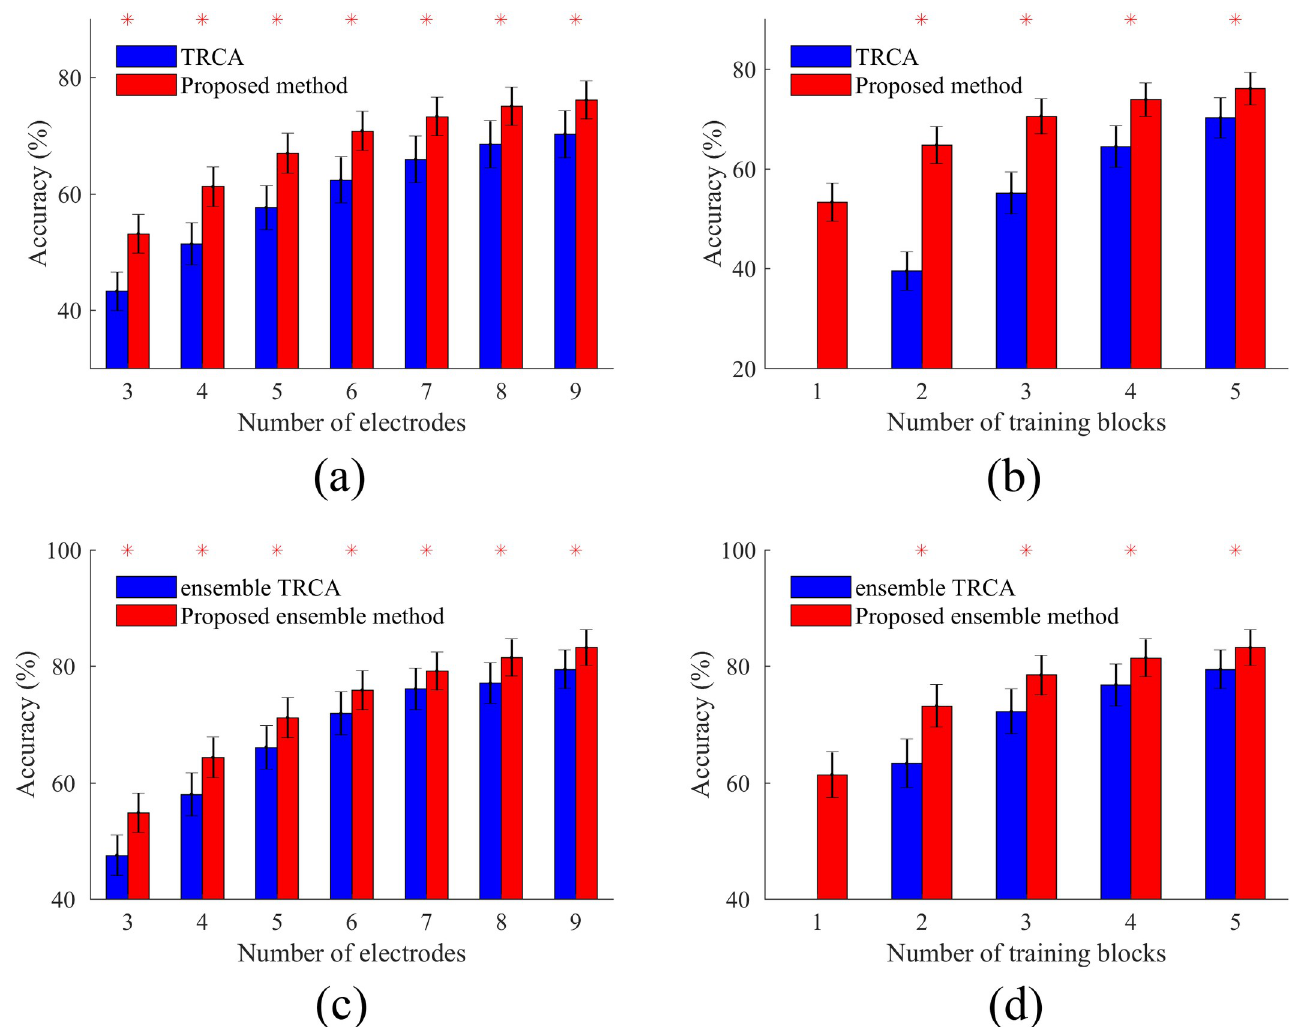
Fig 6. Average accuracies across subjects obtained by different number of electrodes, (a) and (c), and training blocks, (b) and (d). The first row compares two basic methods and the second row compares two ensemble methods. Asterisks show significant differences between the two methods by paired t-tests ( � p < 0.001). Error bars show standard